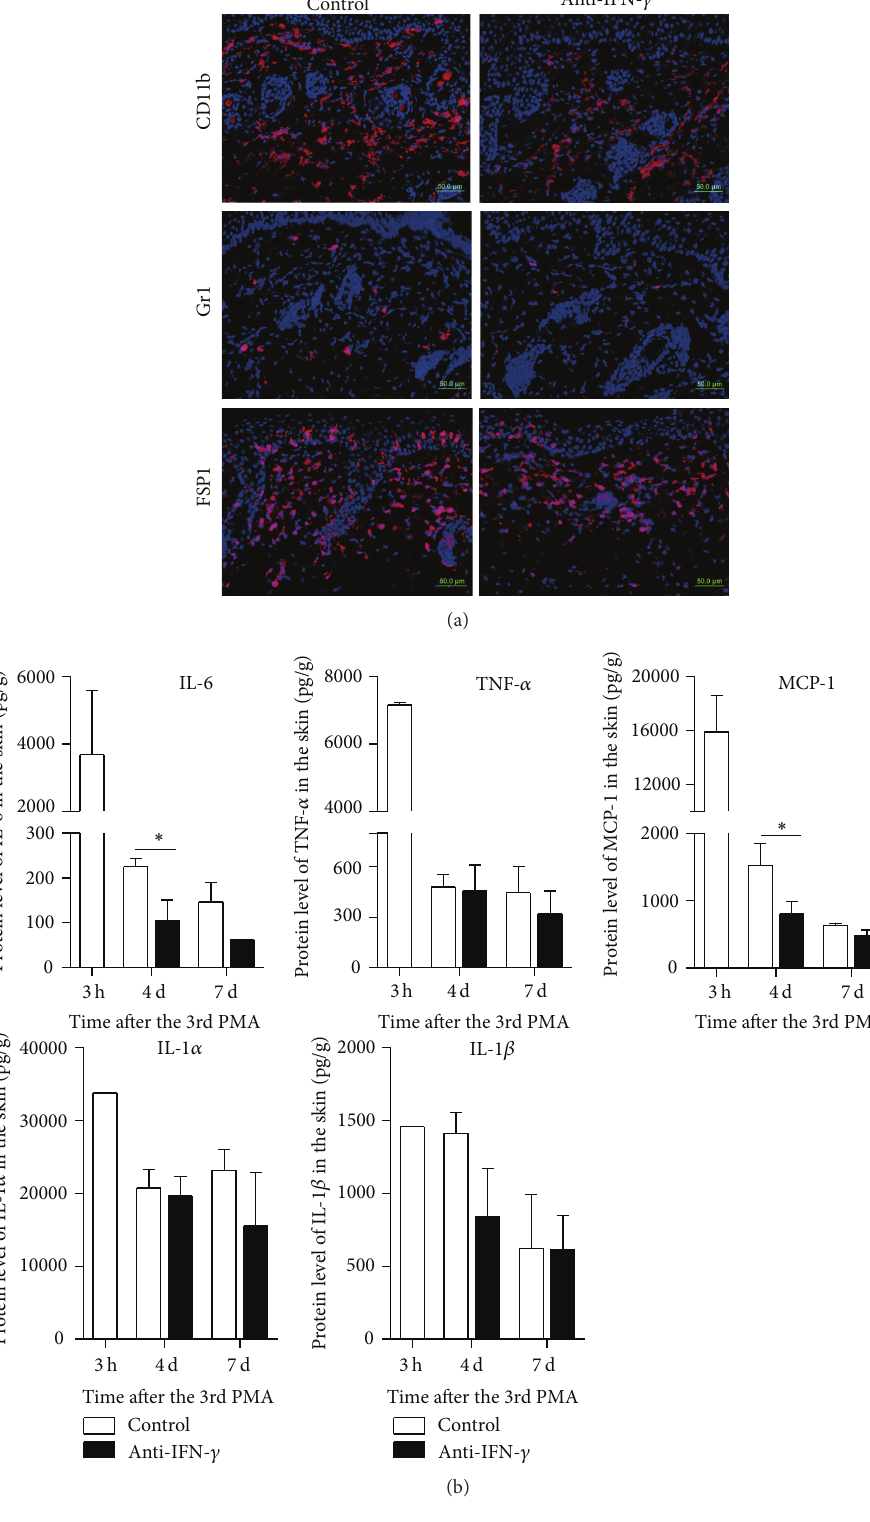
Figure 3: Neutralization of endogenous IFN- 𝛾 decreased the infiltration of inflammatory cells and the production of inflammatory cytokines in the skin. Mice were sacrificed 3 hours, 4 days, or 7 days after the third PMA treatment. (a) Skin sections were stained with anti-CD11b, anti-Gr1, or anti-FSP1 (red). Nucleoli were stained with DAPI (blue). Scale Bar, 50 𝜇 m. (b) The expression levels of IL-6, TNF- 𝛼 , MCP-1, IL-1 𝛼 , and IL-1 𝛽 of the skin from control group or anti-IFN- 𝛾 group were detected at indicated time points. ∗ 𝑃 < 0.05 , compared to control